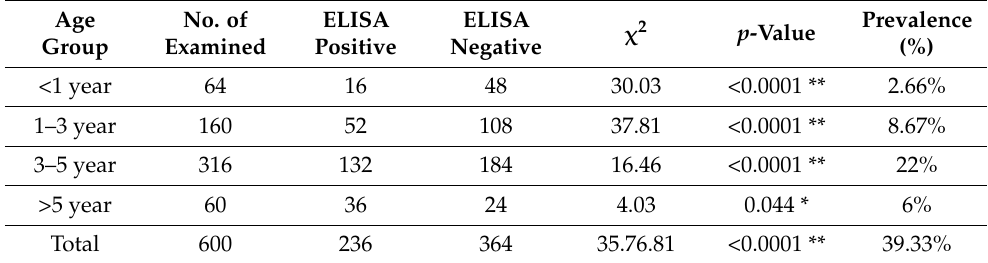
Table 3. Prevalence of leptospirosis in cattle according to age group.